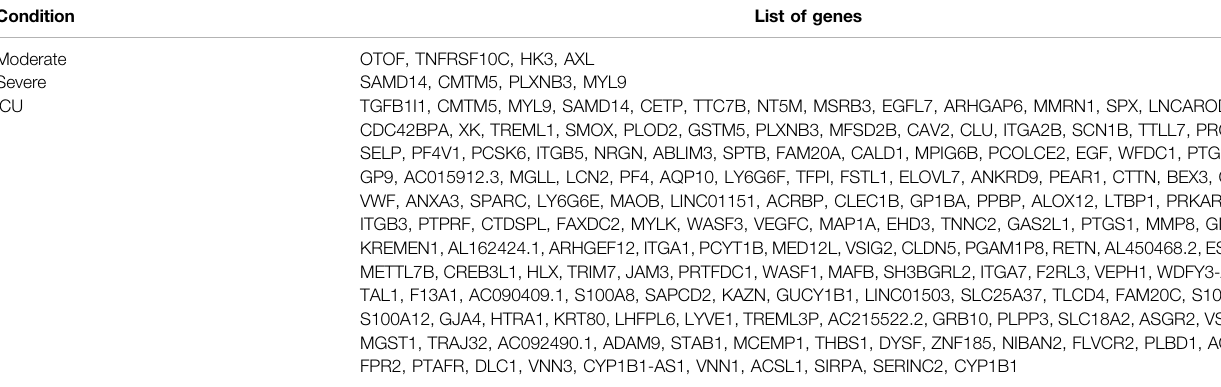
TABLE 6 | List of genes that are differentially expressed in GSE152418.